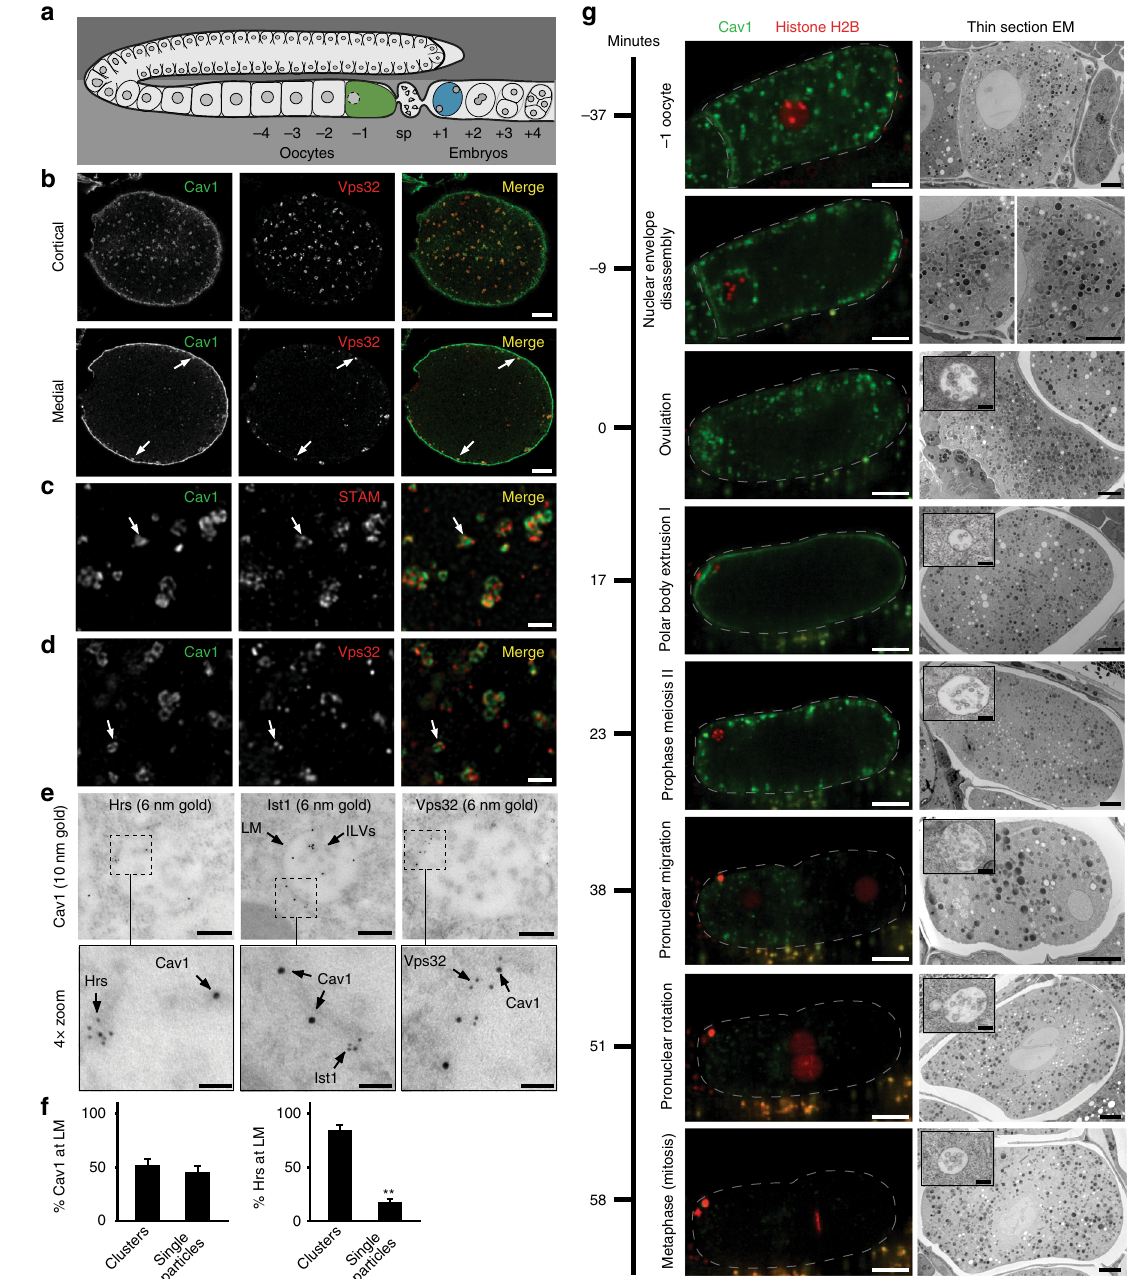
Fig. 1 De novo MVE biogenesis initiates near the cortex of C. elegans zygotes. a Cartoon depicting the C. elegans reproductive system. Oocytes are fertilized as they pass through the spermatheca (sp) and develop as embryos within the uterus. b Embryos expressing GFP::Cav1 were fi xed and stained using antibodies directed against GFP and Vps32 and imaged using confocal microscopy ( n = 6). Representative images are shown. Arrows highlight cortical endosomes that are positive for both Cav1 and Vps32. Bars, 5 μ m. c , d Higher magni fi cation of embryos described in panel b imaged using STED microscopy. Arrows highlight the presence of endosomal subdomains harboring STAM ( n = 5, c ; ESCRT-0) or Vps32 ( n = 5, panel d ; ESCRT-III), while Cav1 is more uniformly distributed. Bars, 1 μ m. e Animals were high-pressure frozen and processed for immunogold labeling using antibodies directed against Hrs (6 nm gold, left, n = 28 MVEs), Ist1 (6 nm gold, middle, n = 16 MVEs), or Vps32 (6 nm gold, right, n = 11 MVEs), together with antibodies against GFP:: Cav1 (10 nm gold). The limiting membrane (LM) and intralumenal vesicles (ILVs) are indicated with arrows (top, middle panel). Representative images are shown. Bars, 200 nm (top panels) and 50 nm (bottom panels). f Based on the distribution of gold labeling at the endosome limiting membrane (LM) described in panel e , the percentages of Cav1 and Hrs in clusters/subdomains (de fi ned as 2 or more gold particles within 20 nm) or individual gold particles was quanti fi ed. Standard error of the mean is shown in each case. ** p < 0.01, using a t -test. g Animals expressing GFP::Cav1 and RFP::His58 (Histone H2B) were imaged using time lapse confocal microscopy during ovulation and early embryogenesis (left panels; oocyte and embryo are outlined, n = 12 animals). Corresponding thin-section electron microscopy studies were conducted at the indicated time intervals (right panels). Representative images are shown. Bars, 10 μ m (left panels), 4 μ m (right panels), and 200 nm (right panel insets highlighting